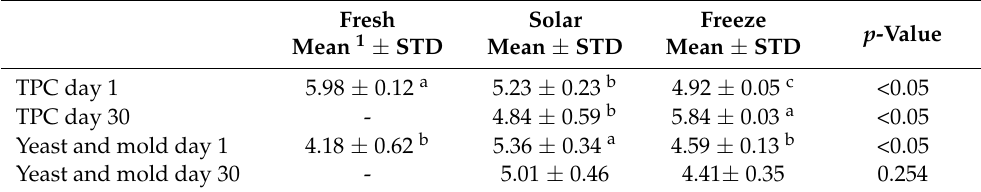
Table 4. Microbiological analysis for fresh, freeze-, and solar-dried O. syriacum .